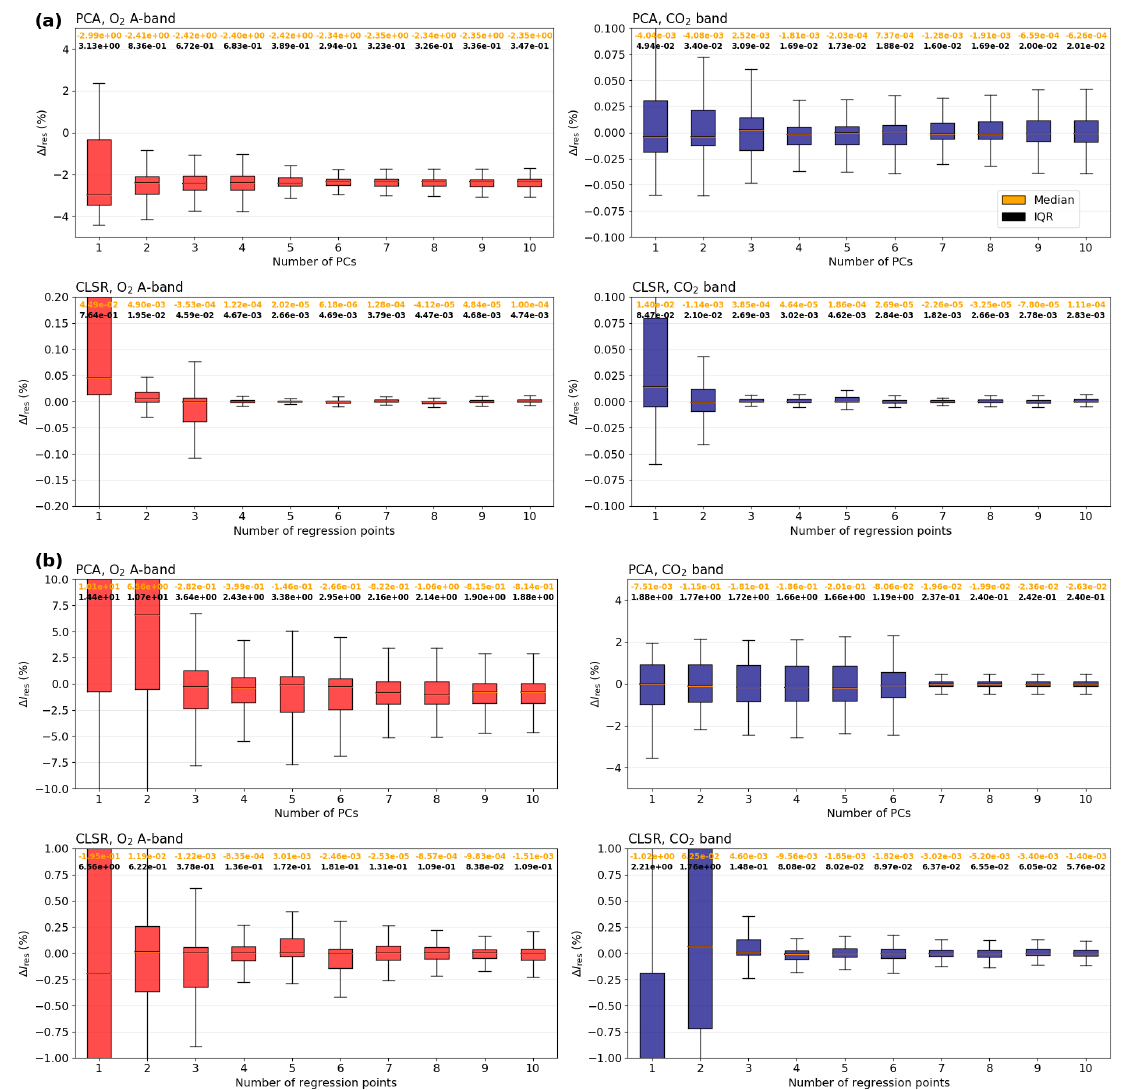
Figure 6. Box plots of the residuals with respect to the continuum in percentage for (upper panels) the PCA model and (bottom panels) the CLSR method, when the low-stream model is ( a ) the two-stream model for the ‘Cloud 2’ scenario or ( b ) the single-scattering model for the ‘Aerosol 2’ scenario. The red boxes indicate the O 2 A-band while the blue boxes indicate the CO 2 band. Box description: the upper and lower limits of the box represent the interquartile range (IQR), which is ( Q 3 − Q 1 ) being Q i the i -th quartile; the upper and lower whiskers indicate ( Q 3 + 1.5 · IQR) and ( Q 1 − 1.5 · IQR), respectively; the orange line inside the box represents the median; the orange values on top of each box indicate the median values and the black values correspond to the IQR